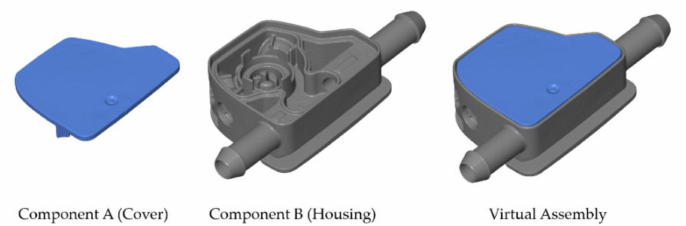
Figure 1. Exemplary virtual assembly of the use case outlined in Section 4.